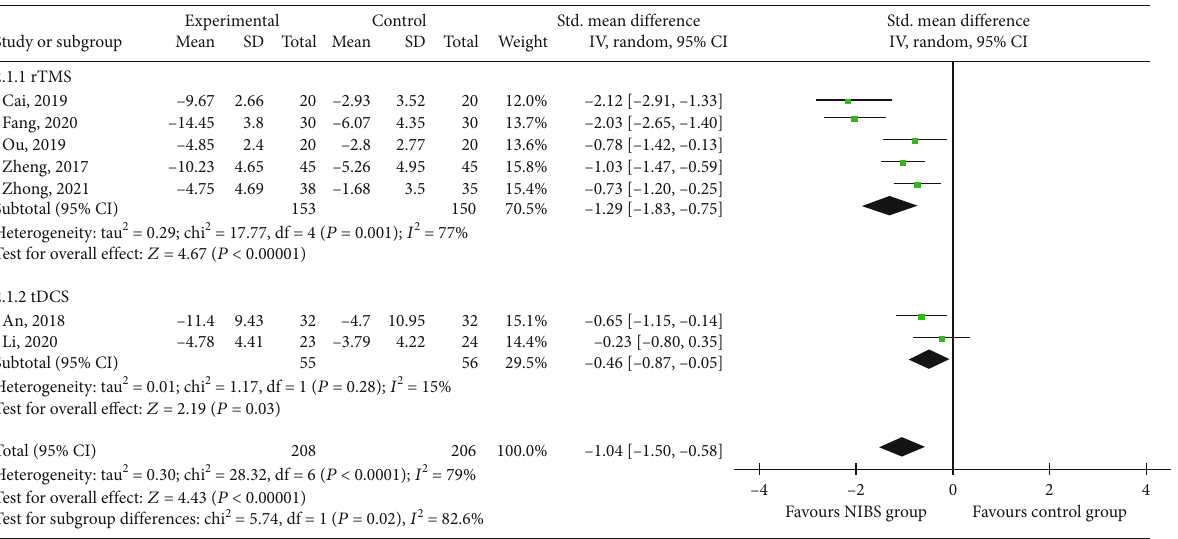
Figure 4: E ff ects of NIBS on SSA scores of patients with dysphagia after